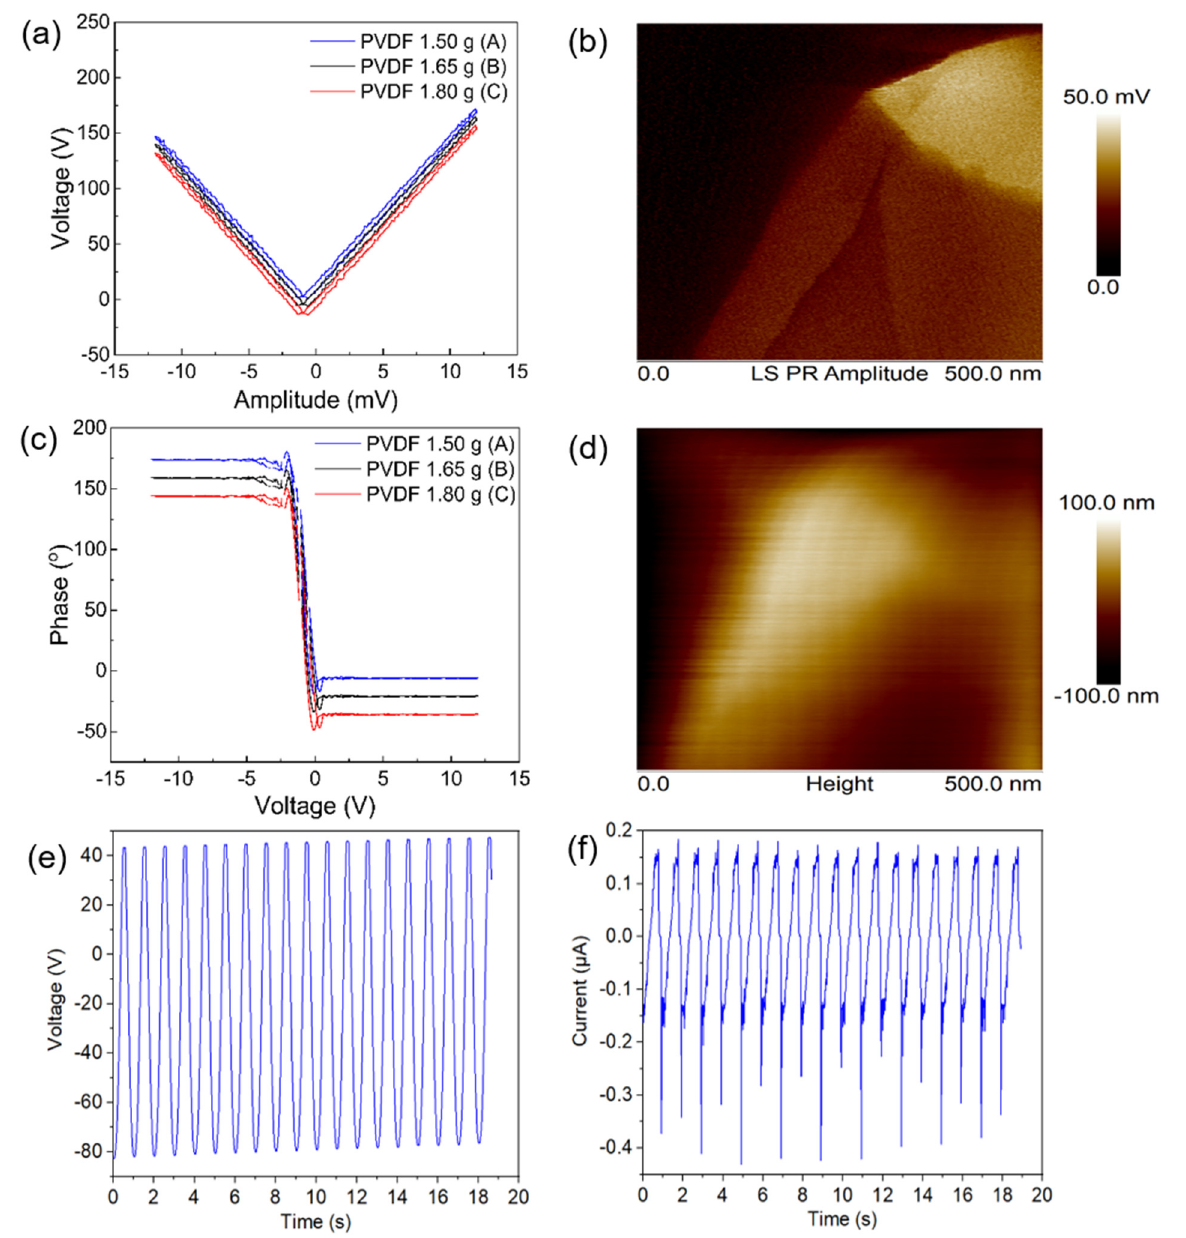
Figure 8. ( a – f ) Piezoresponse hysteresis loops for samples A, B and C and piezoresponse force microscope (PFM) phases and corresponding amplitude hysteresis in response to the applied voltage bias for samples A, B and C, and 7 ( e , f ) electrical response of electrospun PVDF nanofibers mat with 15% wt. PVDF under applied force of 50 N.